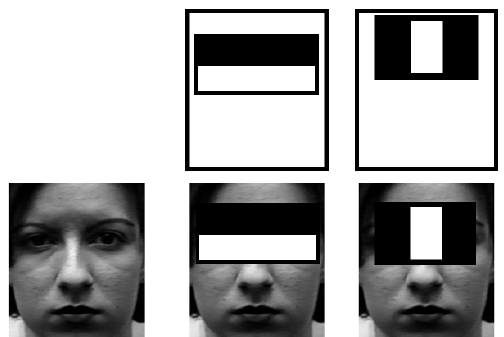
Figure 5. Features selected by the AdaBoost learning algorithm in a face from the CK+ database.